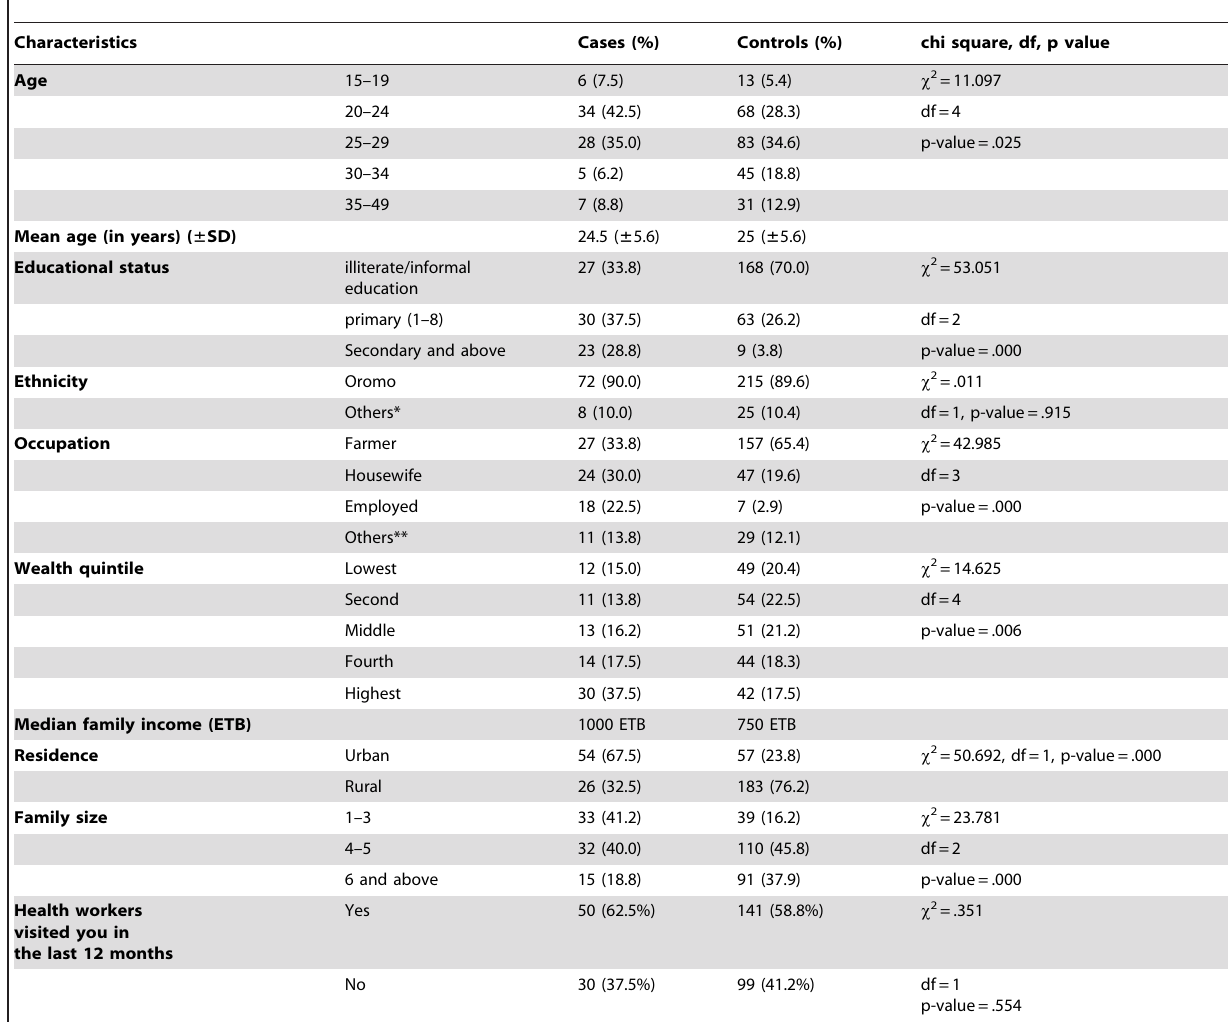
Table 1. Socio-demographic characteristics of study participants in Western Ethiopia, October